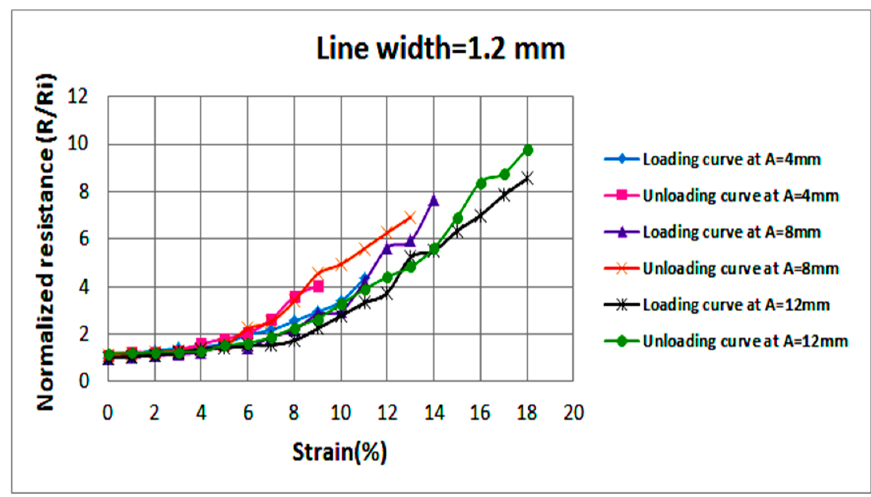
Figure 8. Average normalized resistances of two sinusoidal samples at a line width of 1 mm and various amplitudes as the applied strain increases (loading) and decreases (unloading).